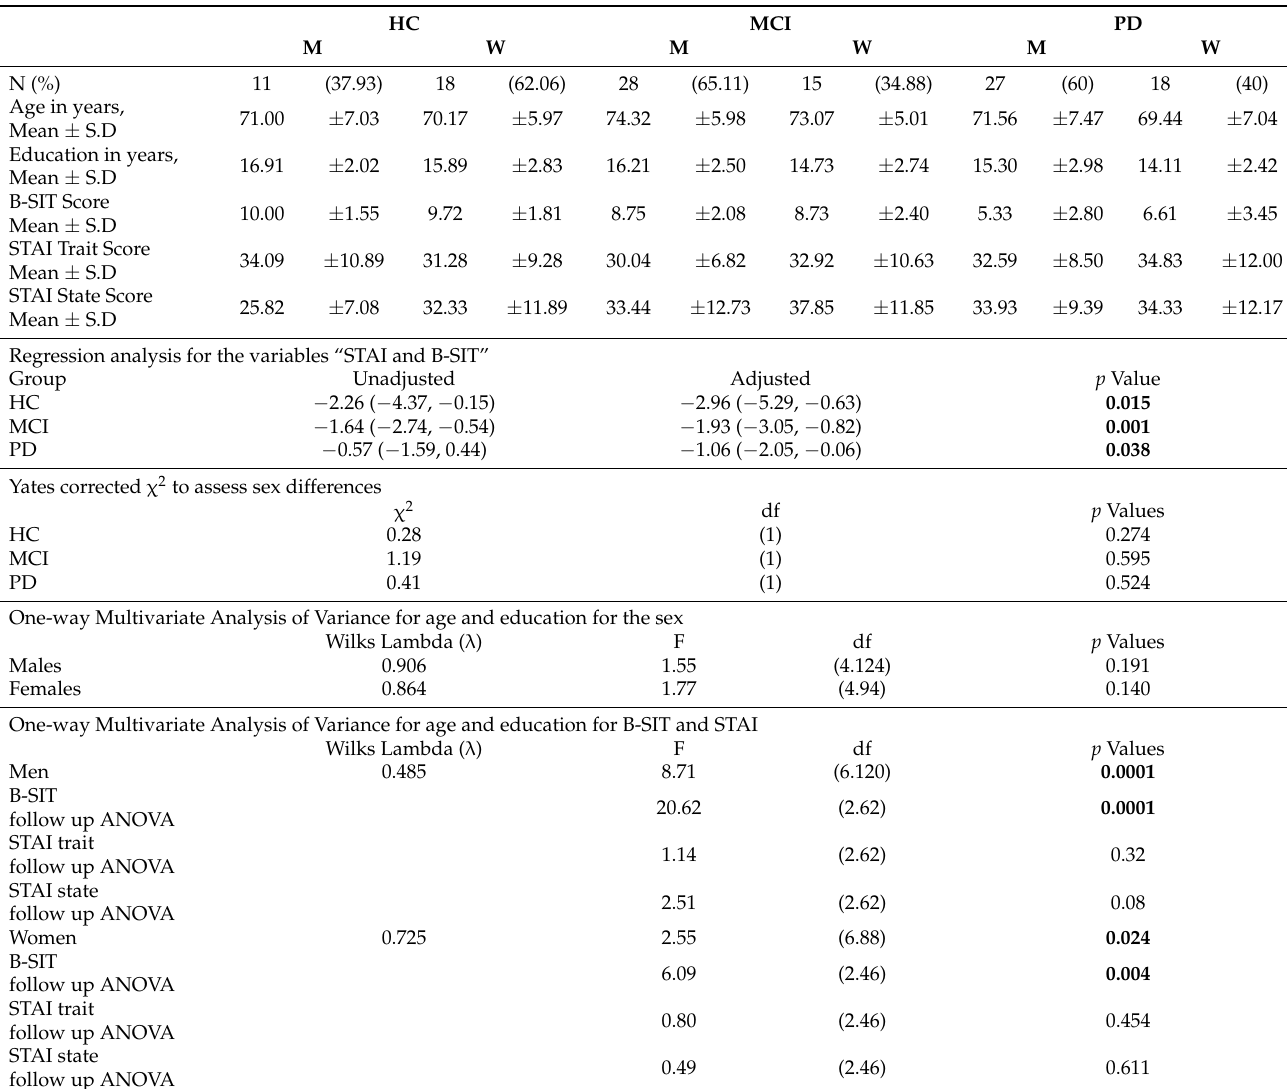
Table 1. Descriptive and regression analysis for the variables STAI Traits and B-SIT, adjusted for age, gender, and education. p -values for the adjusted models, adjusted for age, gender, and education.